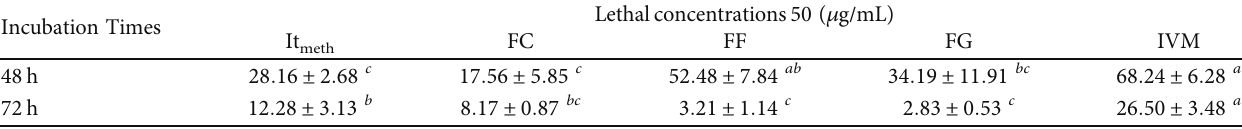
) of methanolic crude extract and chromatographic fractions. 50